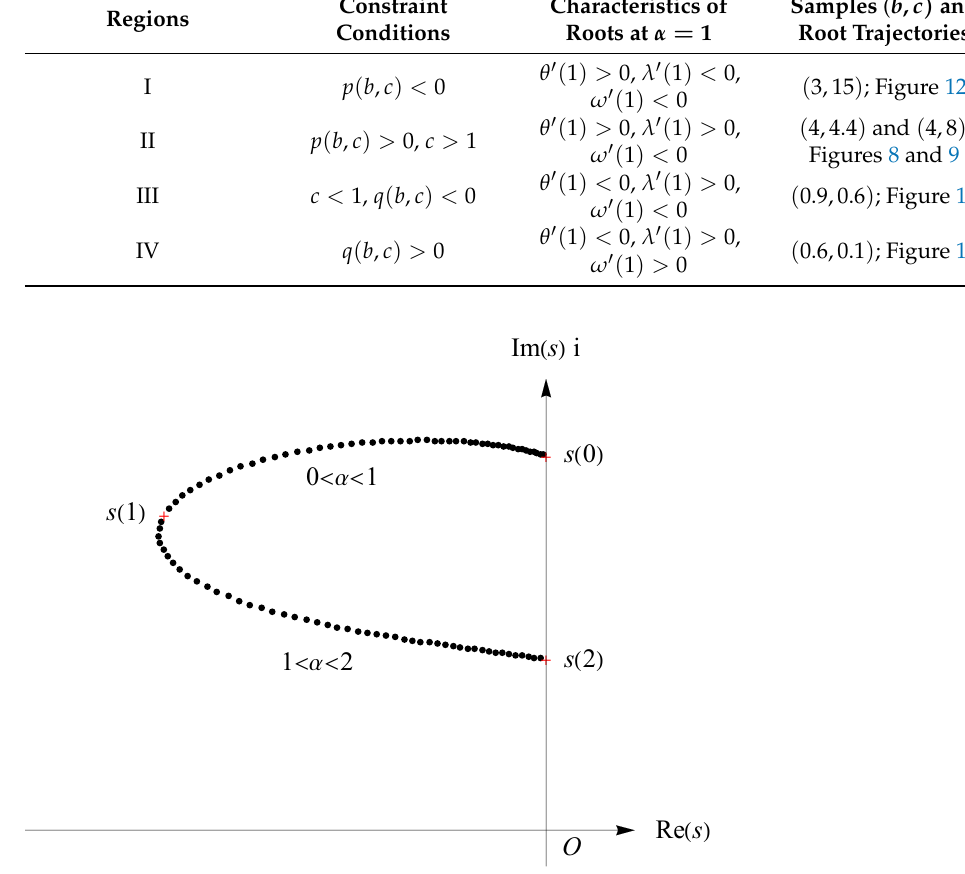
Figure 12. Trajectory of roots s ( α ) for α varying between 0 and 2, where b = 3 and c = 15 ( b 2 − 4 c < 0, region